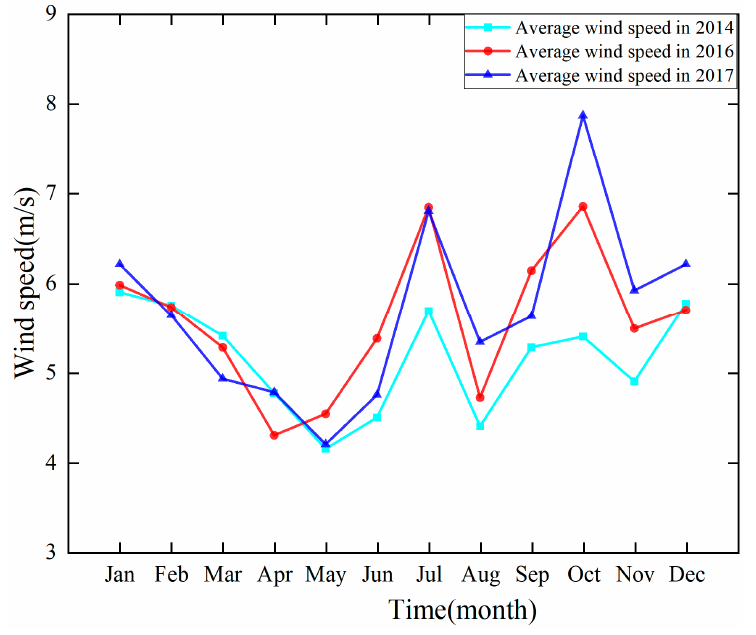
Figure 6. Average monthly wind speed over 3 years.